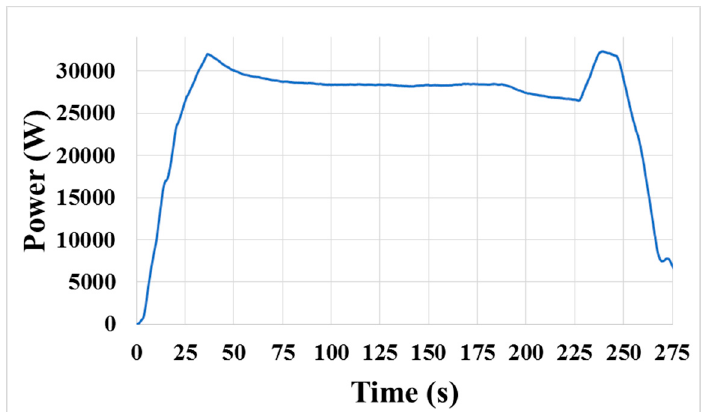
Figure 13. Smoothed signal curve obtained by the revised average method.